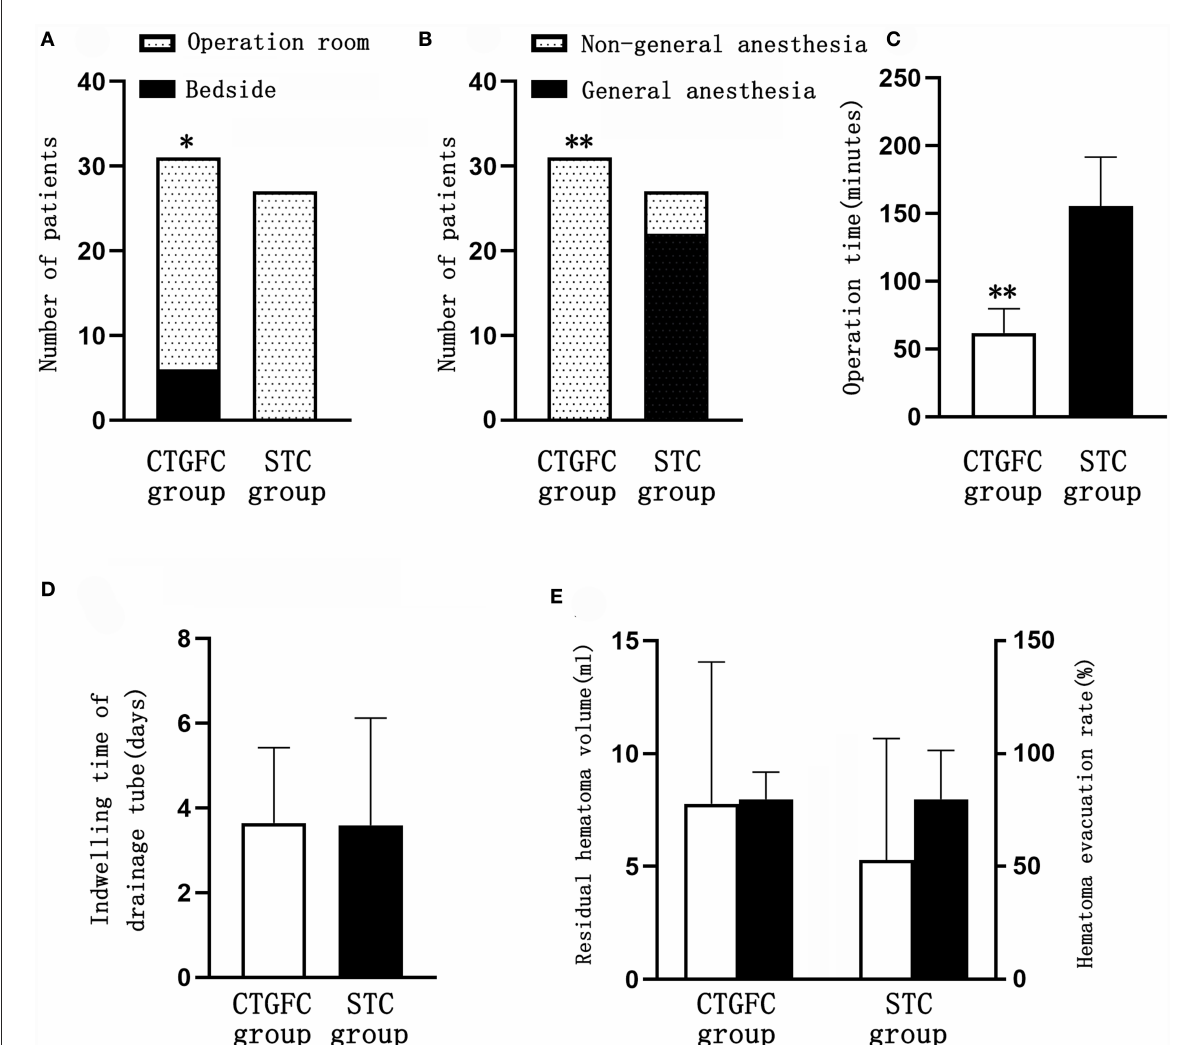
FIGURE3 Comparison of operation-related indicators between the two groups. (A) Site of surgery. (B) Mode of anesthesia. (C) Operation time. (D) Catheter indwelling duration. (E) Residual hematoma volume and hematoma evacuation rate. * p < 0.05 and ** p < 0.01 vs. the stereotaxic surgery group. CTGFC, CT image-guided free-hand catheter technique; STC, stereotactic catheter technique.